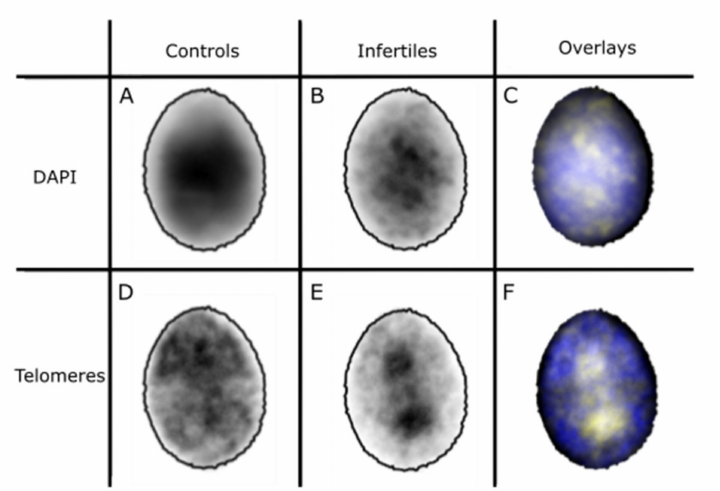
Figure 5. Telomere and DAPI (corresponding to chromatin) distributions in fertile and infertile cohorts. Panel ( A ): DAPI heatmap for control cohort warped onto consensus nucleus for control cohort. Panel ( B ): DAPI heatmap for infertile cohort warped onto consensus nucleus for control cohort. Panel ( C ): Merged heatmaps of DAPI staining for both control (blue) and infertile (yellow) cohorts. Panel ( D ): Telomere heatmap for control cohort warped onto consensus nucleus for control cohort. Panel ( E ): Telomere heatmap for infertile cohort warped onto consensus nucleus for control cohort. Panel ( F ): Merged heatmaps of telomere staining for both control (blue) and infertile (yellow)